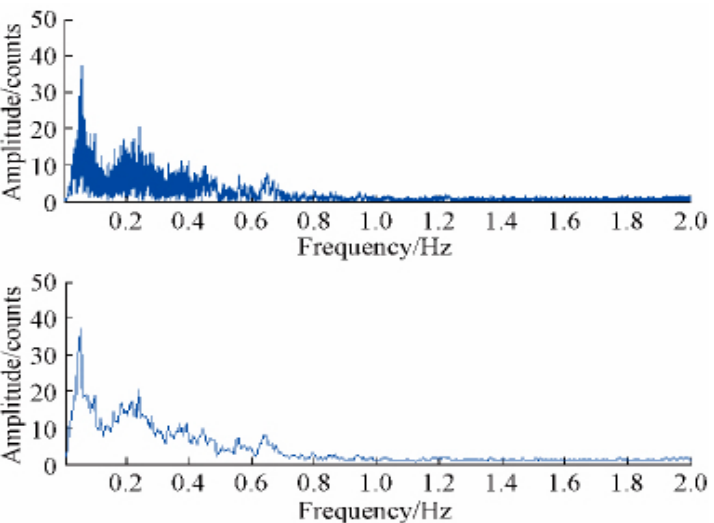
Figure 4. Spectrum envelope of Shizuishan (SZS) station at 5:00 on 6 April 2015.